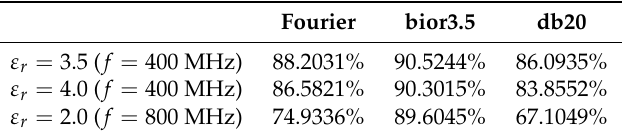
Table 2. Energy compression ratio of induced currents using 2-level wavelet approximate components and low-frequency Fourier components (256 bases).